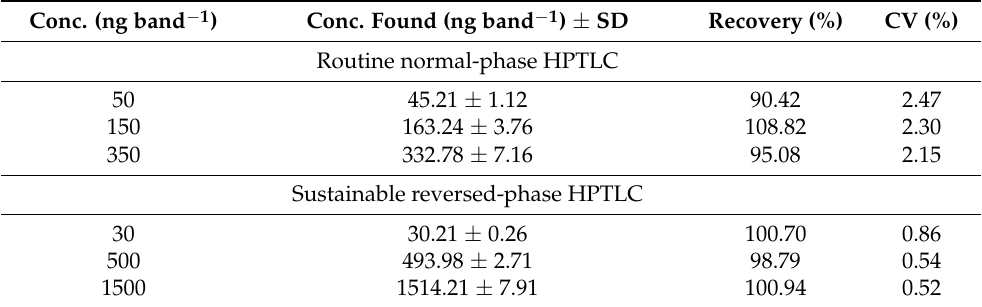
Table 3. Measurement of accuracy of PT for the routine normal-phase HPTLC and sustainable reversed-phase HPTLC techniques (mean ± SD; n =